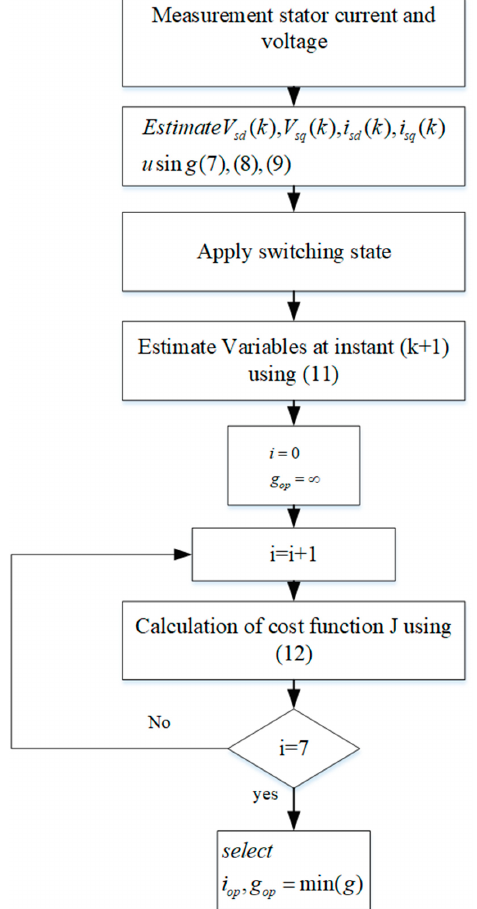
Figure 8. Flow chart of the proposed modulated model predictive control (MMPC) system.